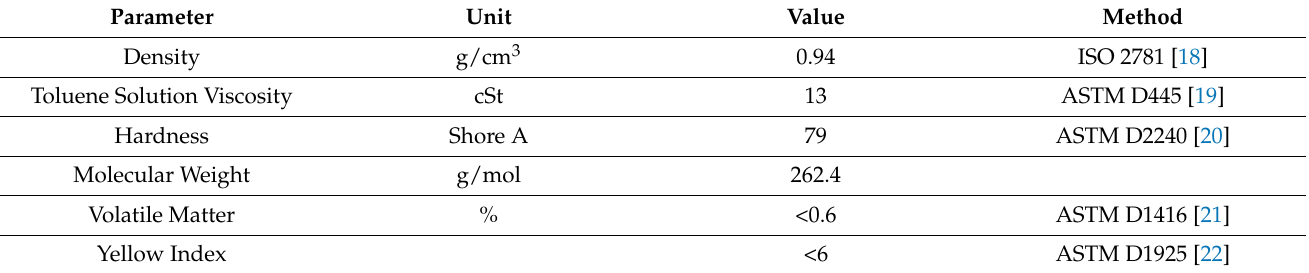
Table 2. Properties of SBS.